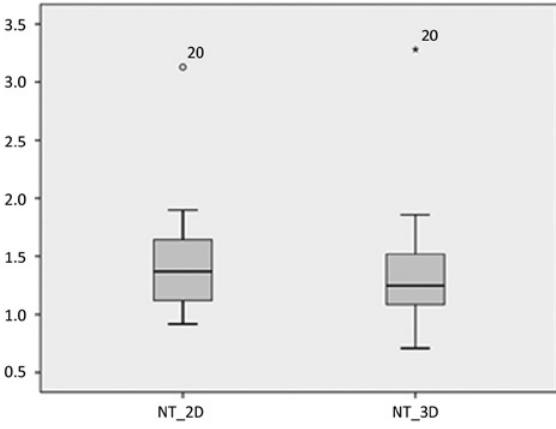
Fig. 8 - Boxplot of nuchal translucency thickness (mm) in relation to 2D and 3D measurements (Sample size